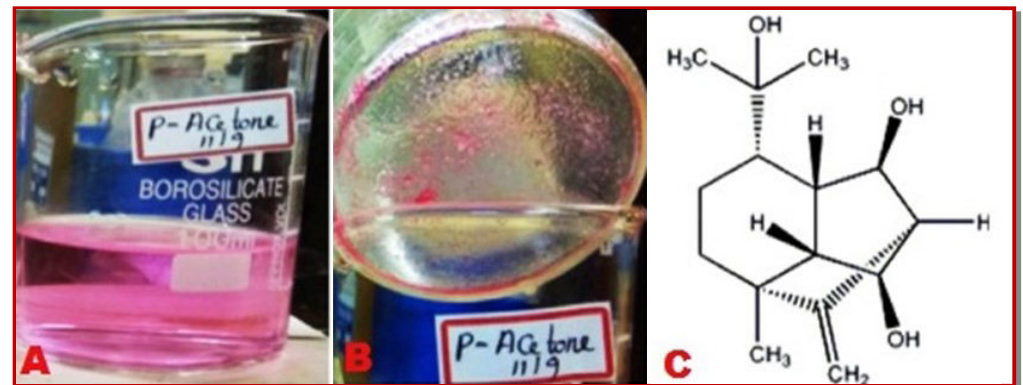
Figure 1: Isolation of metabolite from Cochliobolus spp. A) Acetone soluble fraction; B) Dried acetone fraction (pink oily); C) Struc- ture of isosativenetriol